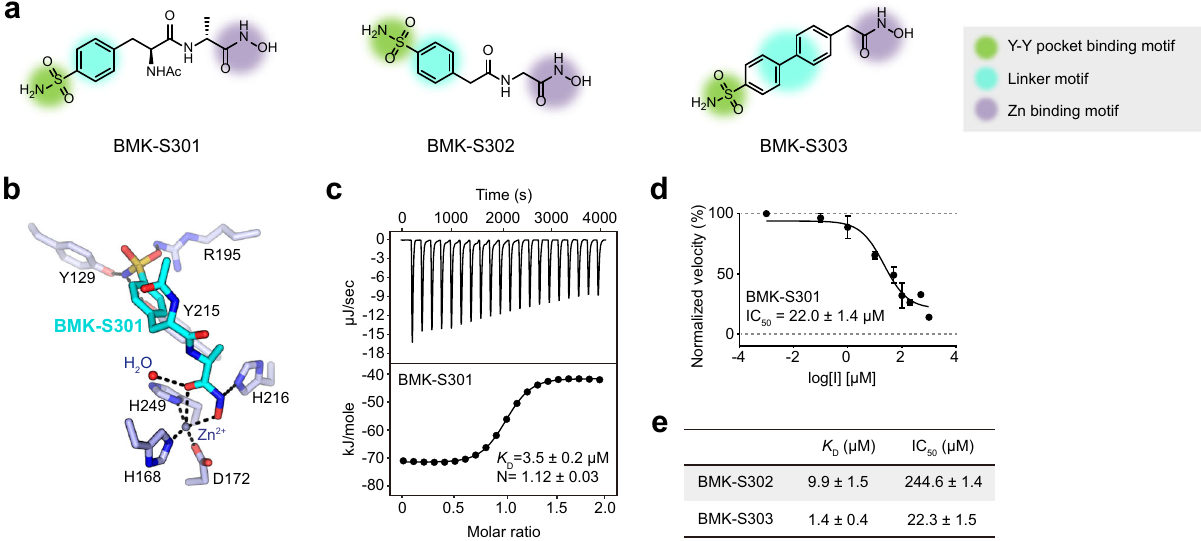
Fig. 4 Structural and functional studies on Pgp3 in complex with BMK-S301 and its derivatives. a Chemical structures of BMK-S301 and its derivatives (BMK-S302 and -S303). Green, purple and cyan circles indicate the Y-Y binding motif, Zn binding motif and linker motif, respectively. b Detailed interaction of Pgp3 H247A active sites bound with BMK-S301 (cyan). Key interaction residues in Pgp3 are colored with light blue, whereas Zn 2 + ion is represented by slate gray sphere. Tetrahedral coordination of Zn 2 + and hydrogen bonds are represented by black dashed lines. c The ITC fi tting results of Pgp3 with BMK-S301. The thermodynamic data were collected from titration of inhibitor into Pgp3, and the parameters were calculated by fi tting to a single-binding model. d IC 50 fi tting curves for BMK-S301. The data are presented as means± S.E.M. ( n = 3). e IC 50 and K D value comparisons for BMK- S301 derivatives. The data are presented as means ± S.E.M. ( n =